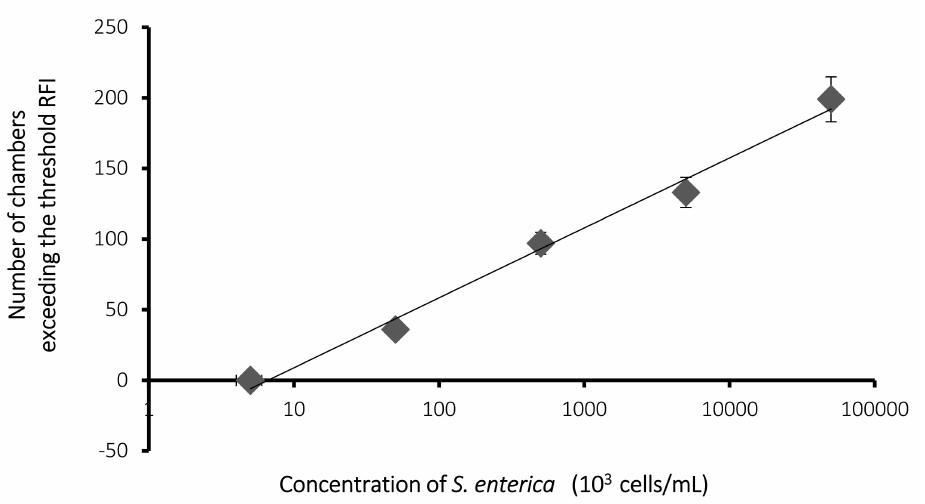
Figure 7. Dependence of the number of microchambers that exceeded the threshold RFI on the concentration of S. enterica . N =